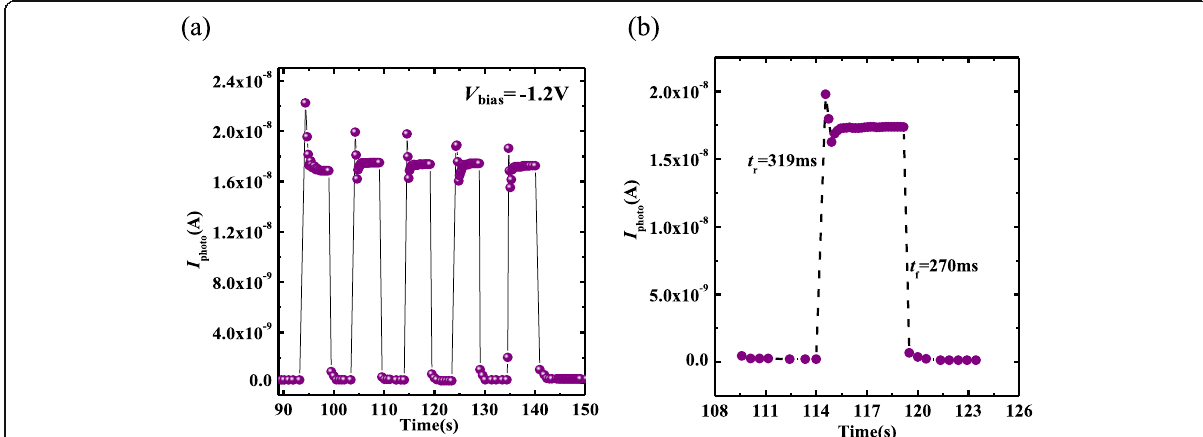
Fig. 5 Multi-cycles ( a ) and single cycle ( b ) of time-dependent I photo of the hybrid PEDOT:PSS/ β -Ga 2 O 3 Schottky barrier photodetector at the V bias = − 1.2 V, the rise time and decay time are determined to be 319 ms and 270 ms, respectively